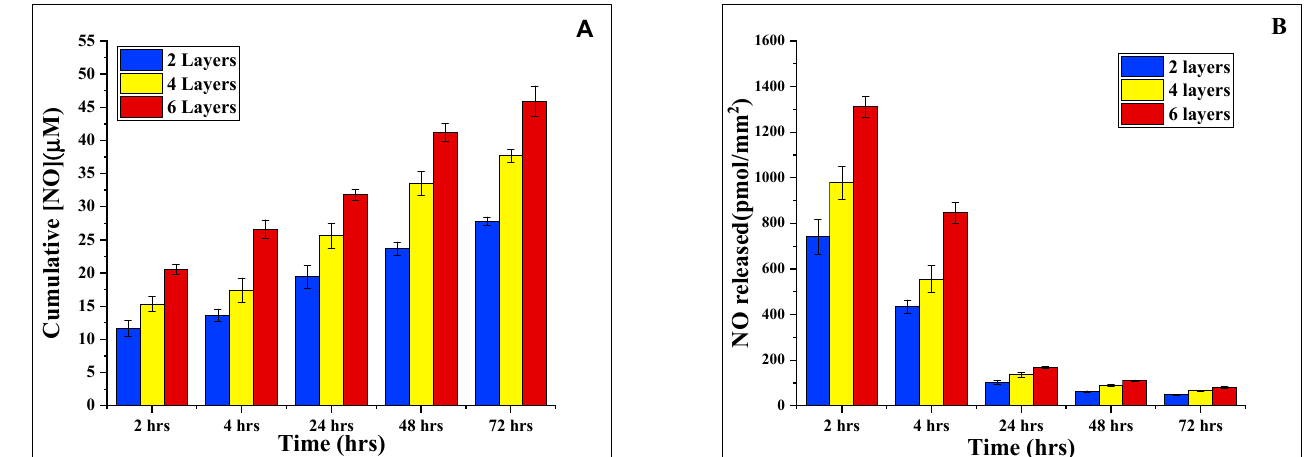
Figure 10. ( A ) Average cumulative NO concentration released from SAP/iNOSox hydrogel for various numbers of PEI/NOS layers over time periods of experiments extending from 2 h to 72 h. ( B ) Corresponding average surface NO flux of SAP/iNOSoxy for the various hydrogels calculated in the form of amounts of NO released per time unit and per unit surface area. Data represents mean ± SD ( n = 3).